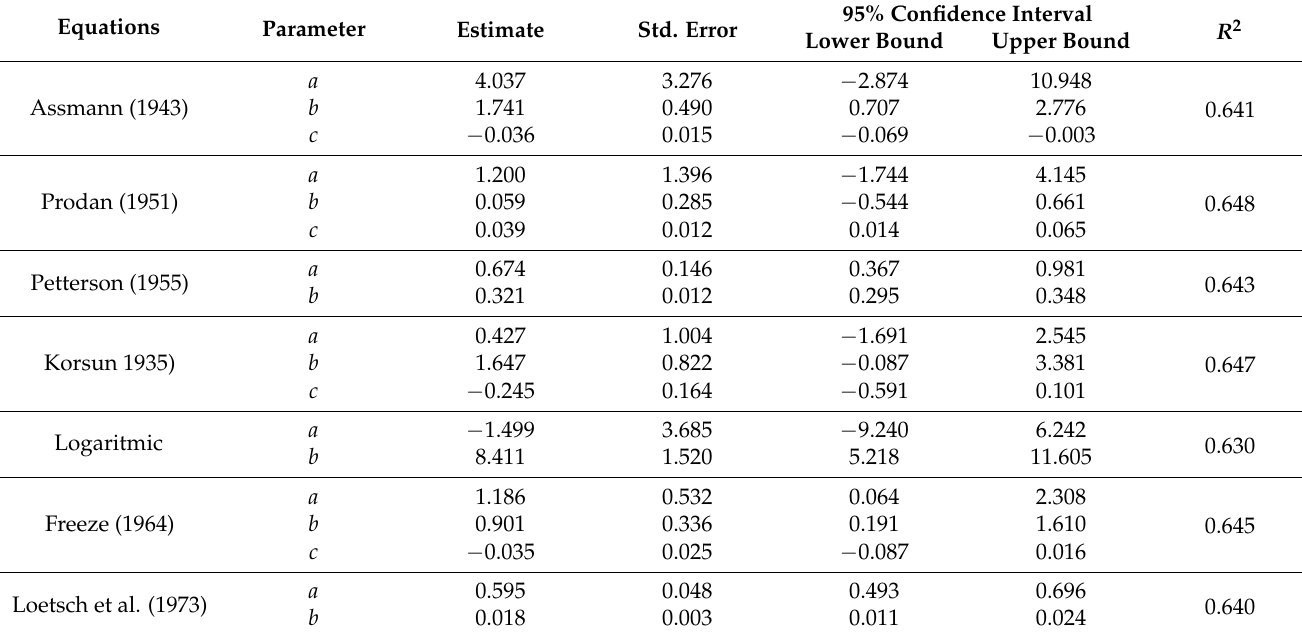
Table 3. Results of the numerical